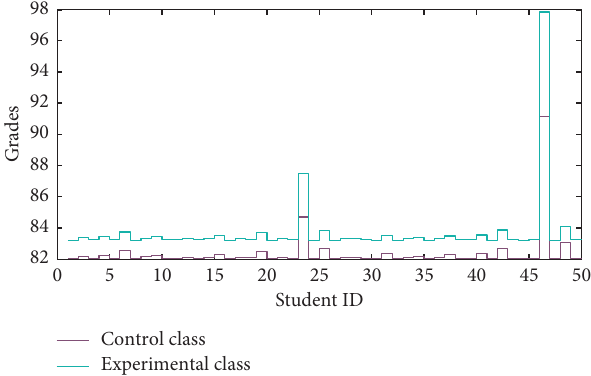
Figure 6: Test results of differences in test results of the experi- mental class and control class.